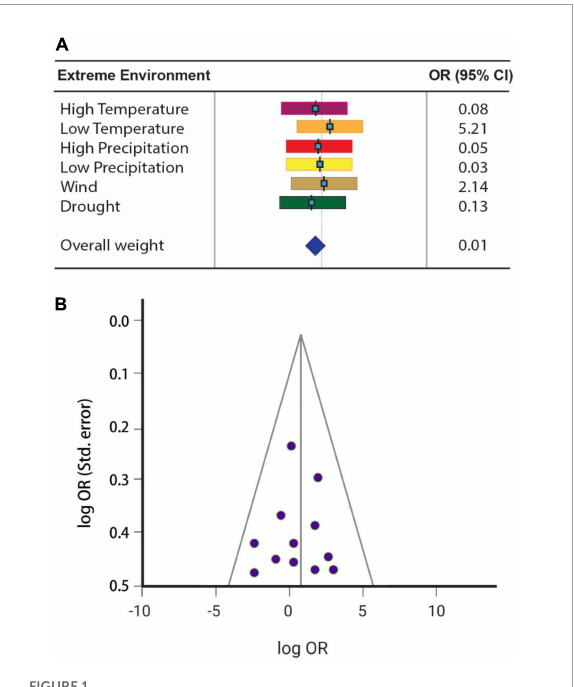
FIGURE1 Forest plot of the procured data for verifying phenology forcing model (A) calculated at a confidence interval of 95%. The funnel plot represents the reliability of the data components based on the log OR-log odds ratio (B) .